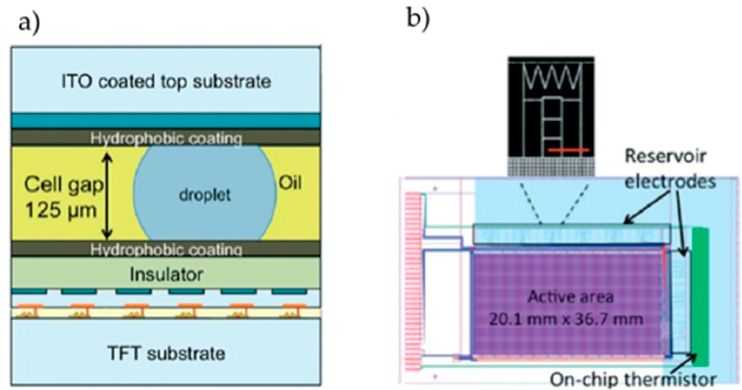
Figure 7. ( a ) Cross-section of the DMF platform, evidencing the several materials that comprise the chip; ( b ) Schematic top view of the chip, evidencing the reservoirs and the temperature sensor. Adapted from original in reference [18].